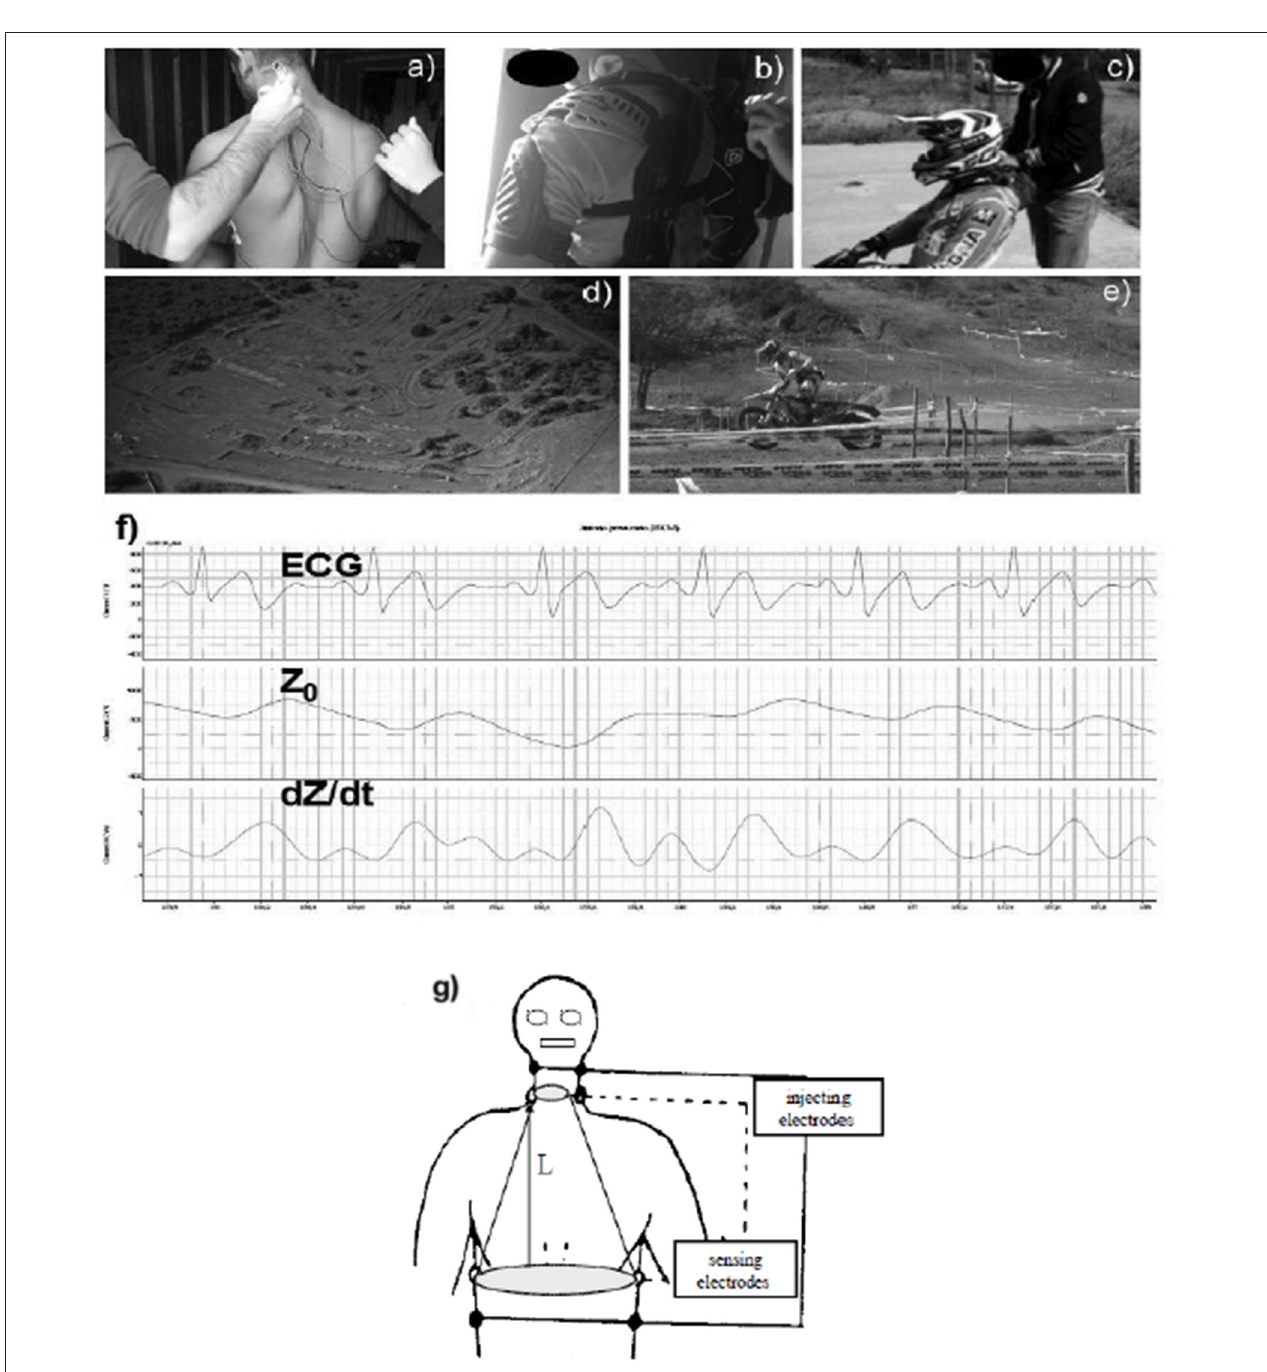
FIGURE 1 | An example of a subject wearing the New Core device. (a) Shows the application of pairs of neck and thoracic electrodes. (b,c) Show the subject after wearing all the Enduro equipment. (d) Is an aerial picture of the Enduro track. (e) Shows the subjects while riding. Finally, (f) Is an example of analog electrocardiogram traces (ECG), thoracic impedance (Z0), and its first derivative (dZ/dt) recorded during the riding session. (g) Is a schematic representation of electrodes